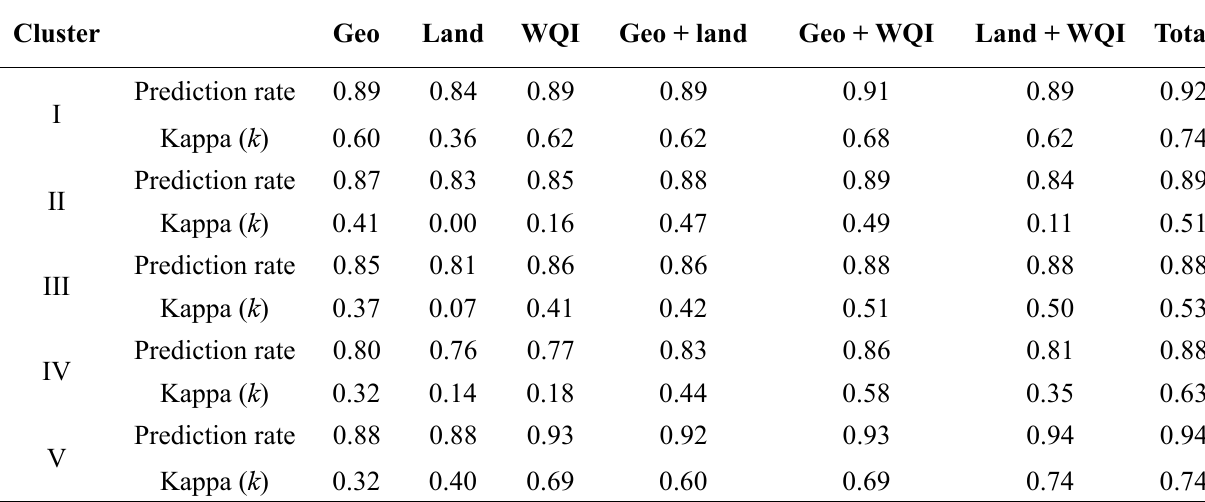
Table 5. Prediction for each cluster using the random forest model with different combinations of environmental